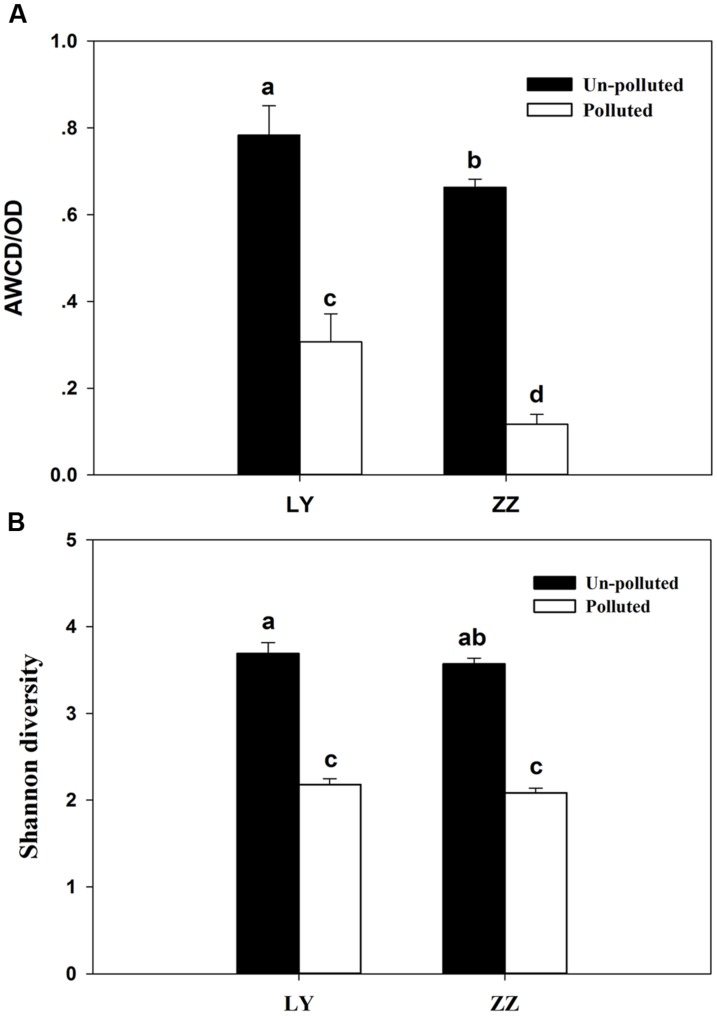
Average well-color development (AWCD; A) and (B) Shannon diversity of soil microbial community. LY and ZZ mean Liuyang and Zhuzhou City, respectively. Error bars are ±standard deviation (n = 5). Columns marked with the same lower-case letter were not significantly different based on Fisher’s protected LSD test (P < 0.05).